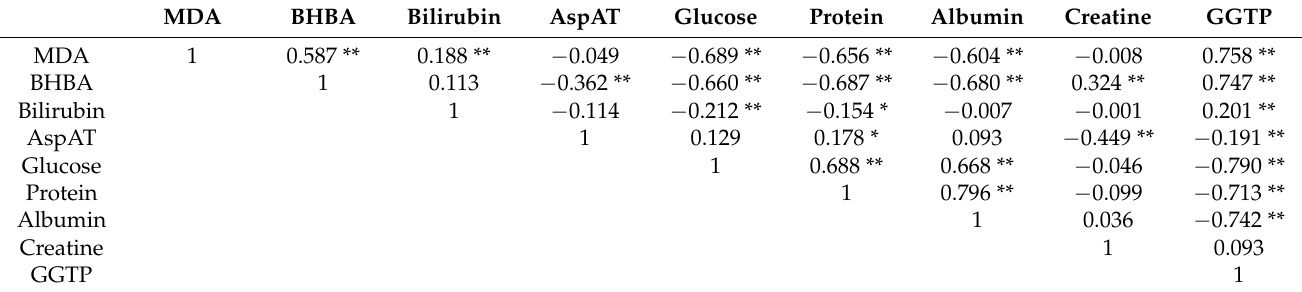
Table 3. Pearson correlations between BHBA and the parameters of metabolic